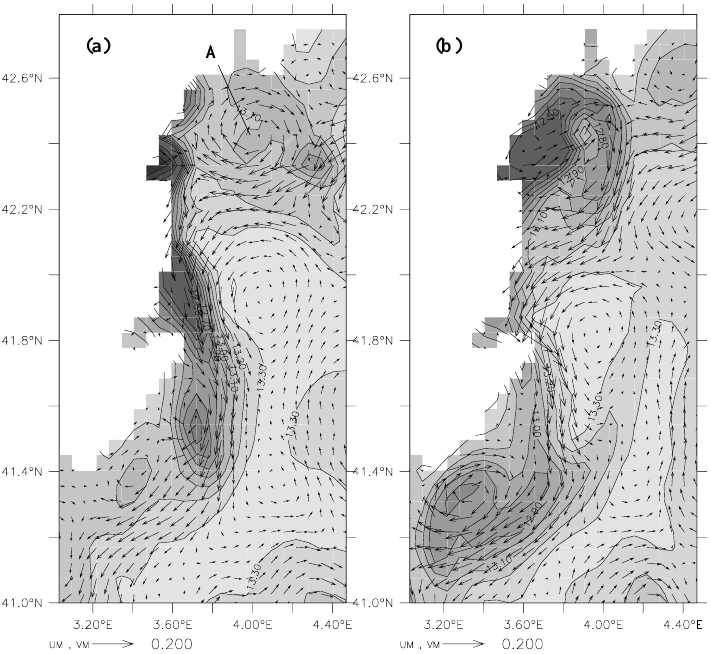
Fig. 15. Temperature (shaded, isotherms in ◦ C) and velocity (arrows, in cm/s) at 400m in the western Gulf of Lions and northern Catalan Sea on: (a) 12 March, year II; (b) 22 March, year II. Isotherms are between 12.5 ◦ C and 13.3 ◦ C at intervals of 0.1 ◦ C. A denotes an anticyclonic eddy propagating westwards with the NC